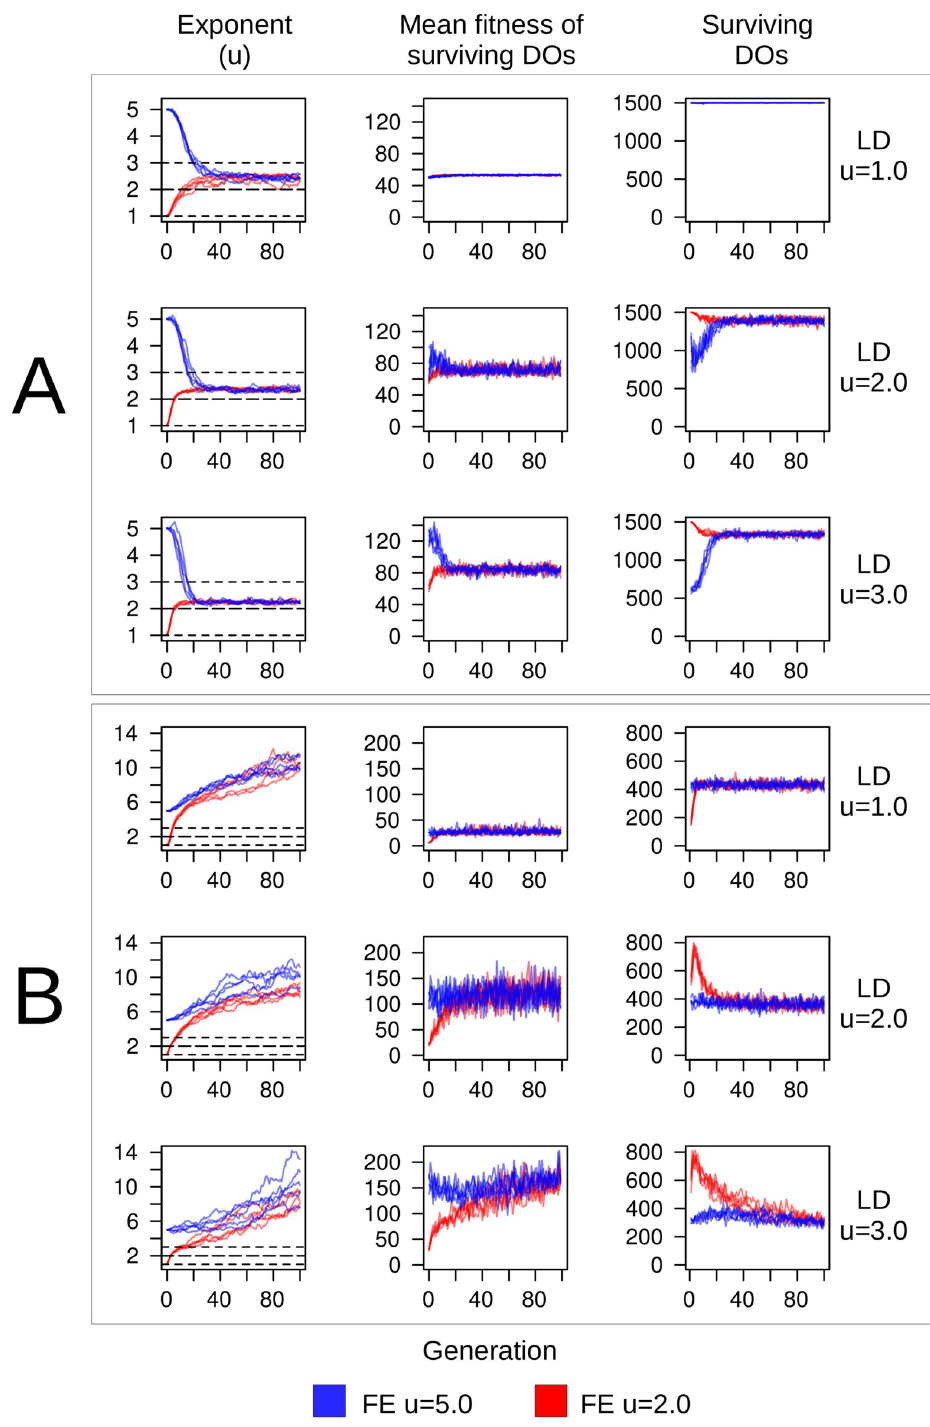
Fig 11. Evolution of DO foraging exponents. Evolutionary simulations of DOs with lifespans of λ = 1M over 100 generations. (A) Searching costs χ = 0. (B) Searching costs χ = 1/8000. Each row comprises ten runs of an initial population of 1500 DOs, five runs starting with mean foraging exponent (denoted as FE) u = 1.0 (red), the remaining five with u = 5.0 (blue), both with σ sv = 0.5. Each row also represents a different environment (RU = Random Uniform, LD = Le´vy Dust where u − 1 = fractal dimension). Note: we exclude the random uniform results as they were simply an intermediate result between the LD u = 1.0 and u = 2.0 results.